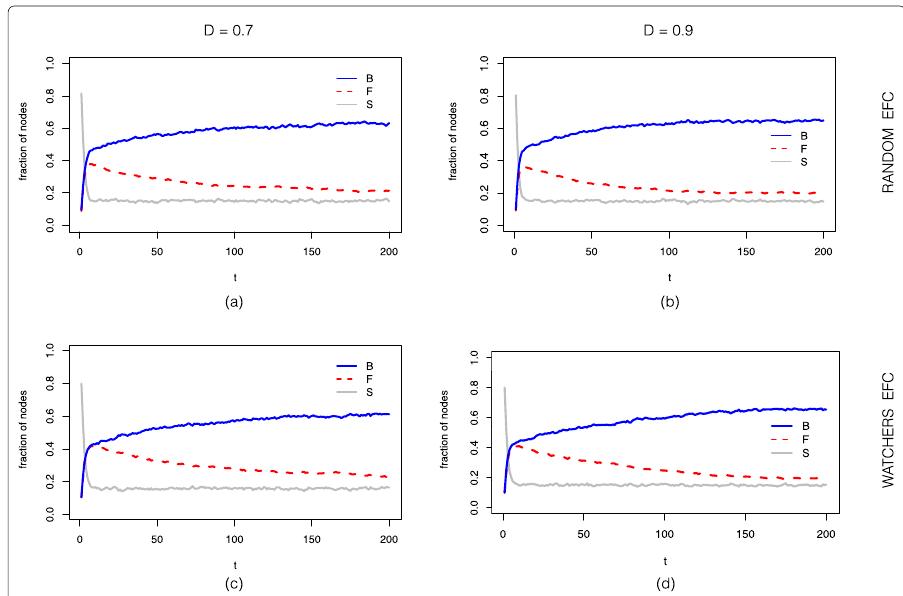
Fig. 9 Schelling Networks. Simulations of the model on grid networks obtained by the Schelling model with a grid size S = 35 and a fixed preference of similar neighbors P = 0.5. Here we considered different values of densities and two strategies of placing 0.1 ∗ N eternal Fact Checkers (eFC): a D = 0.7 and eFC chosen at random in the skeptic group, b D = 0.7 and eFC chosen among the skeptic nodes on the frontier between the two groups, c D = 0.9 and eFC chosen at random in the skeptic community, d D = 0.9 and eFC chosen among the skeptic nodes on the frontier between the two groups. Each plot show the spreading dynamics curves obtained by 20